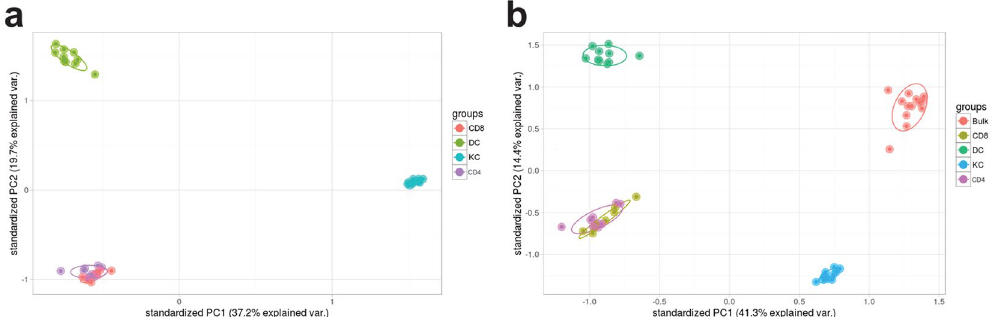
Figure 1. Principal components analysis (PCA) reveals cell populations form distinct clusters. ( a ) First two principal components from PCA of keratinocyte, dendritic cell, CD4 + T cell, and CD8 + T cell populations. ( b ) First two principal components from PCA of populations from ( a ) along with bulk RNA-seq samples.